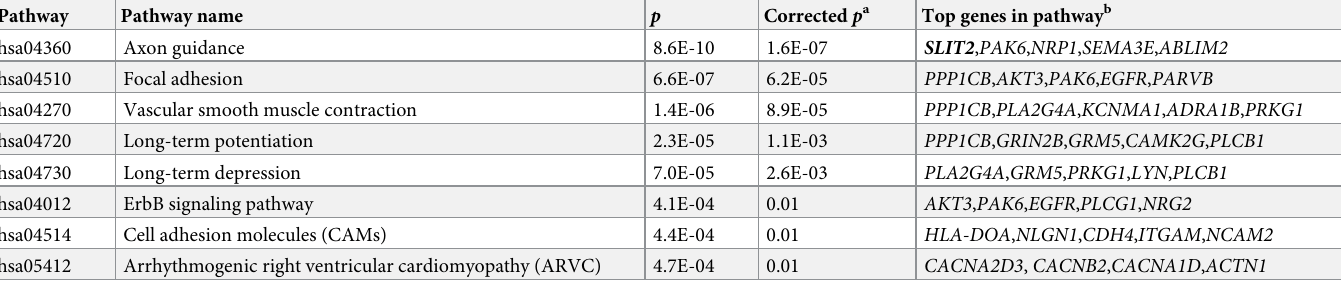
Table 4. Pathways associated with